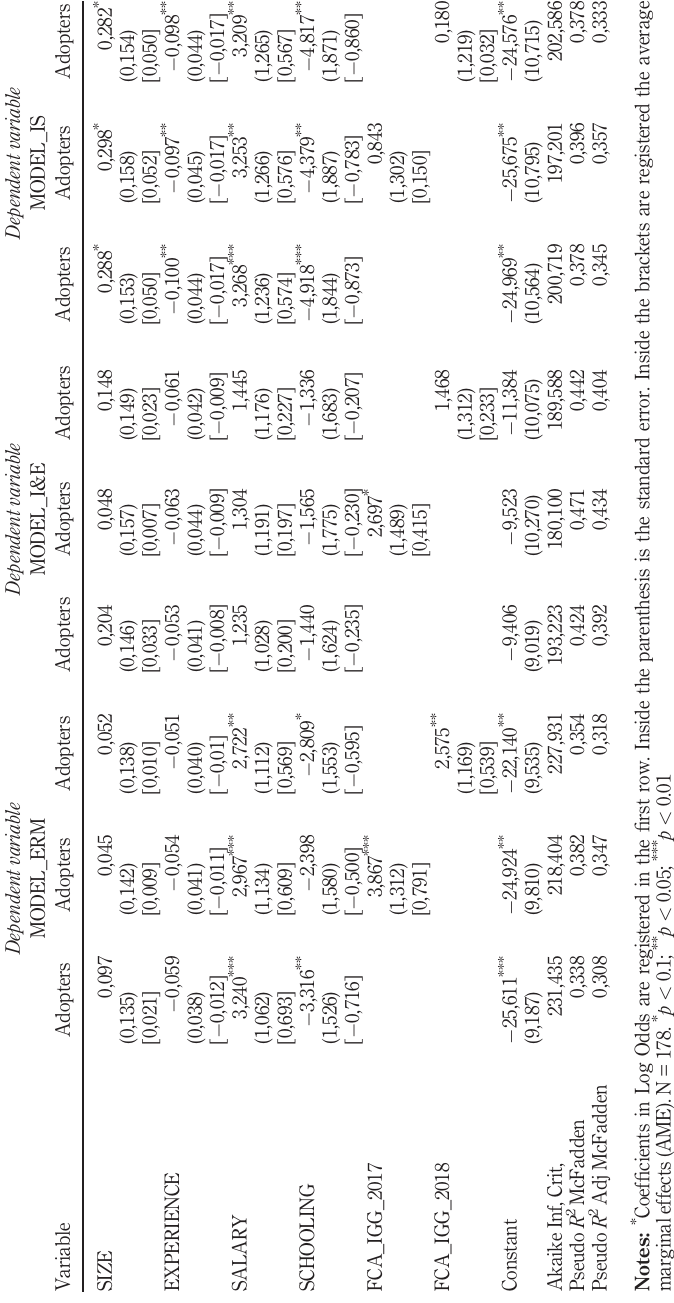
Table 3. Regression